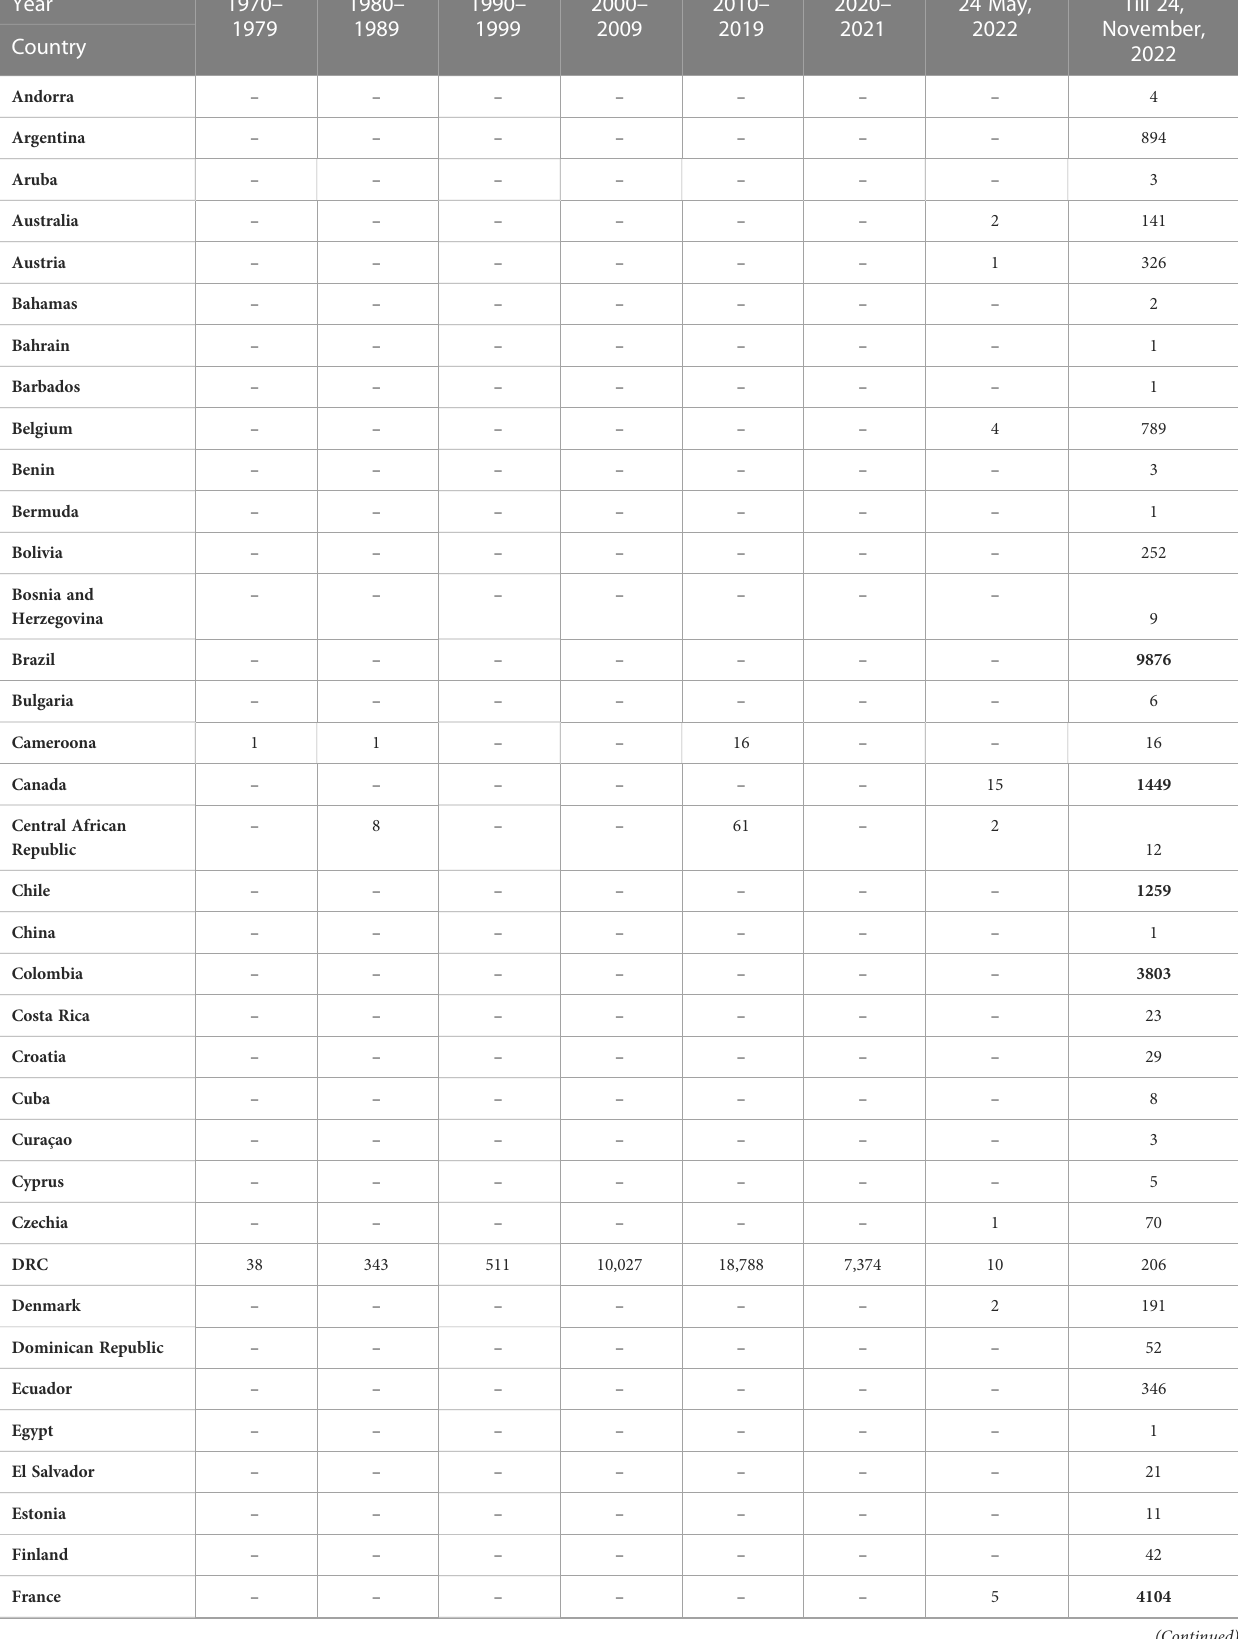
TABLE 1 An overview of monkeypox outbreaks cases between August, 1970 and 24, November,